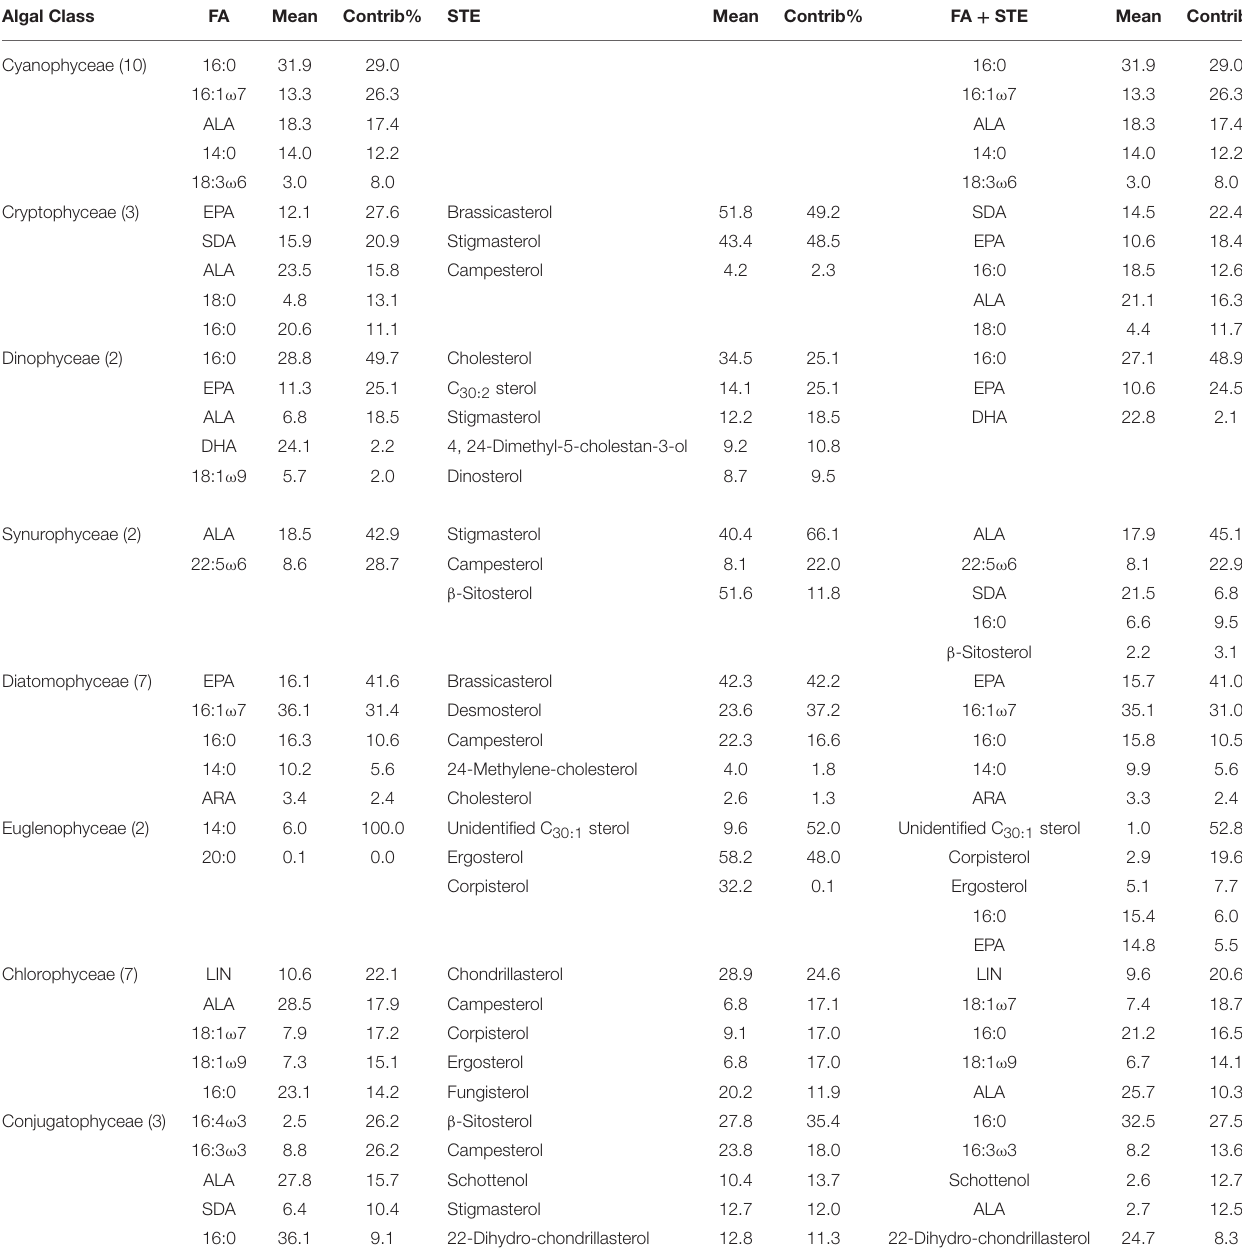
TABLE 5 | Results of SIMPER analysis showing the five most important fatty acids (FA) and sterols (STE) contributing (Contrib%) to similarities within phytoplankton classes. Algal Class FA Mean Contrib% STE Mean Contrib% FA + STE Mean Contrib% Cyanophyceae (10)